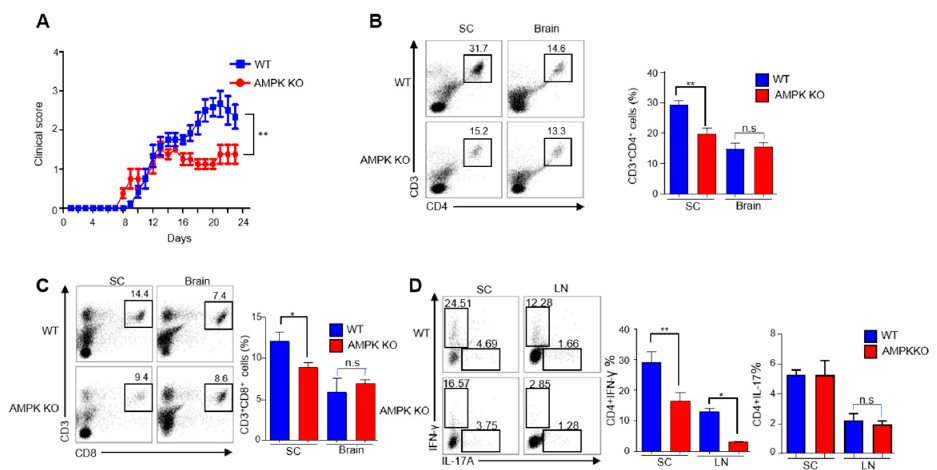
Figure 2. Young AMPK α 1 fl/fl Foxp3 YFP-Cre (AMPK-KO) mice show less inflammatory phenotype than Foxp3 YFP-Cre (WT) mice. Active experimental autoimmune encephalomyelitis (EAE) was elicited and the clinical severity of EAE and cell infiltration in WT and AMPK-KO mice were monitored after immunizing 24–30-week-old C57BL/6J mice with myelin oligodendrocyte peptide. ( A ) Disease severity was measured in terms of clinical score based on the signs and symptoms after inducing EAE in WT and AMPK-KO mice ( n = 5 mice per group). Flow cytometric analysis of the percentage of ( B ) CD4 + and ( C ) CD8 + T cells in total mononuclear cells obtained from spinal cord and brain of EAE-induced WT and AMPK-KO mice. ( D ) Flow cytometric analysis of the percentage of IFN- γ - and IL-17A-producing CD4 + T cells in lymphocytes isolated from spinal cord and lymph nodes from WT and AMPK-KO mice. * p < 0.05, ** p < 0.01 and n.s means non-significant ( p > 0.05).